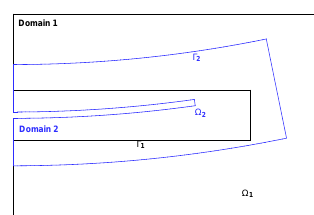
Figure 5. Subdomains of the third model